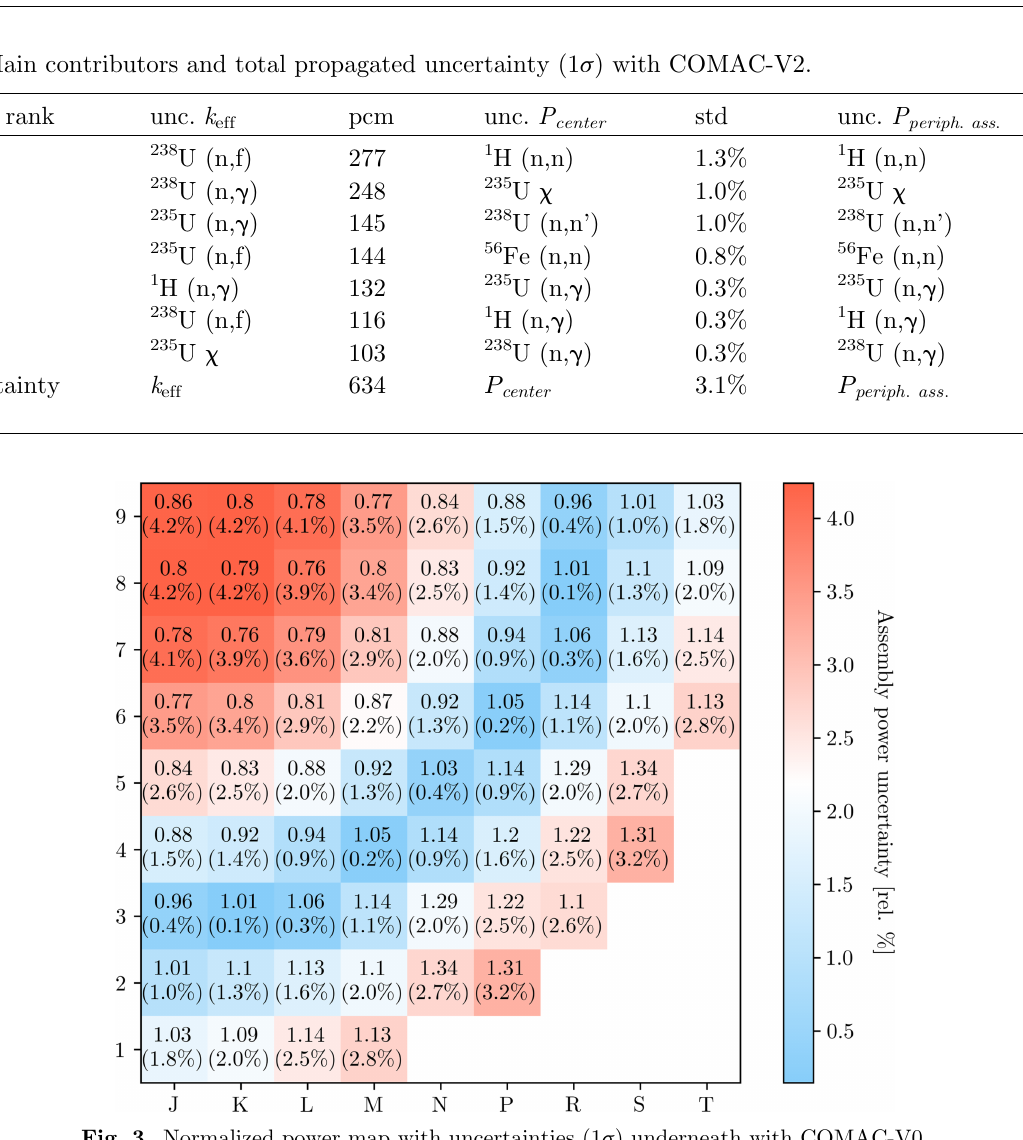
Fig. 3. Normalized power map with uncertainties (1 s ) underneath with